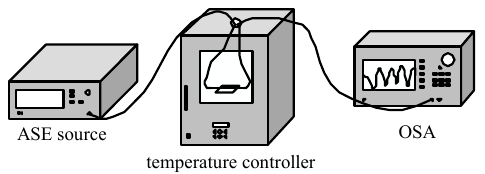
Fig. 12 Temperature experimental setup.